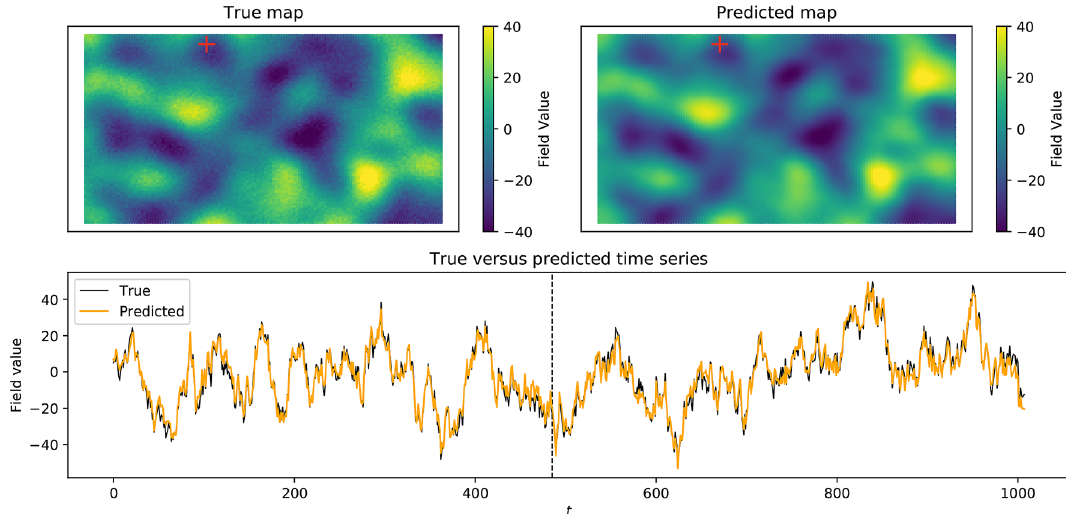
Figure 3. Model outputs for the simulated spatio-temporal field defined by Eq. (2). Top left : A snapshot of the true spatial field at the fixed time indicated by the vertical dashed in the temporal plot below. Top right : The predicted map at the same time. Bottom : The true time series (in black) and the predicted time series (in orange) at the fixed location marked by a cross in the maps